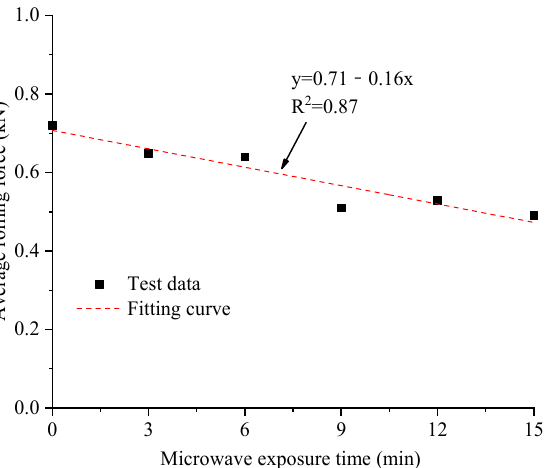
Figure 12. Relationship between the average rolling force and the microwave exposure time.